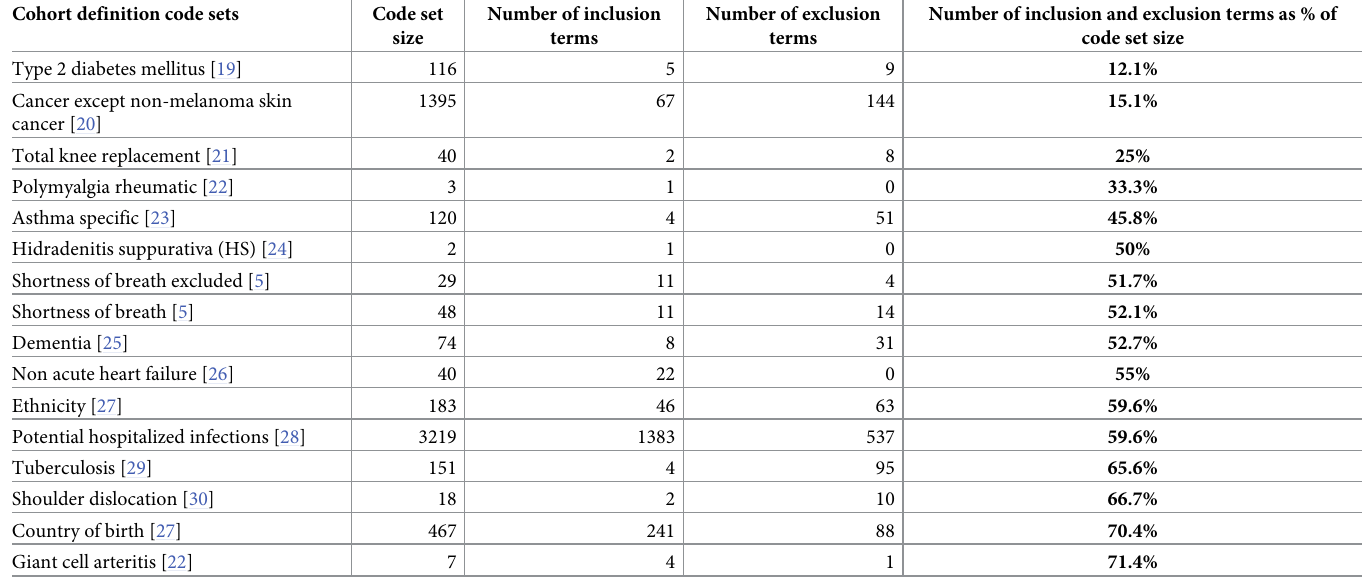
Table 1. Codes set descriptions and sizes, the size of the related inclusion/exclusion term sets, and the inclusion/exclusion term sizes as proportions of the original code set size. Proportions � 100% are displayed in bold. Cohort definition code